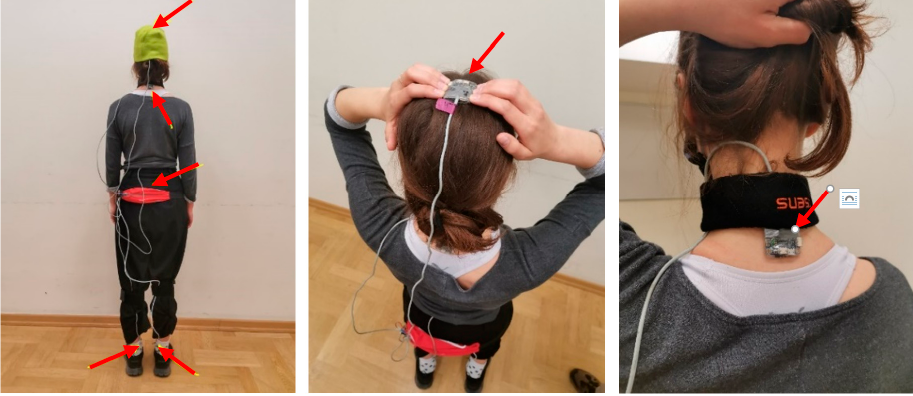
Figure 22. Location of sensors on the human body ( left ), location of the sensor on the head ( middle ) and on the neck ( right ).